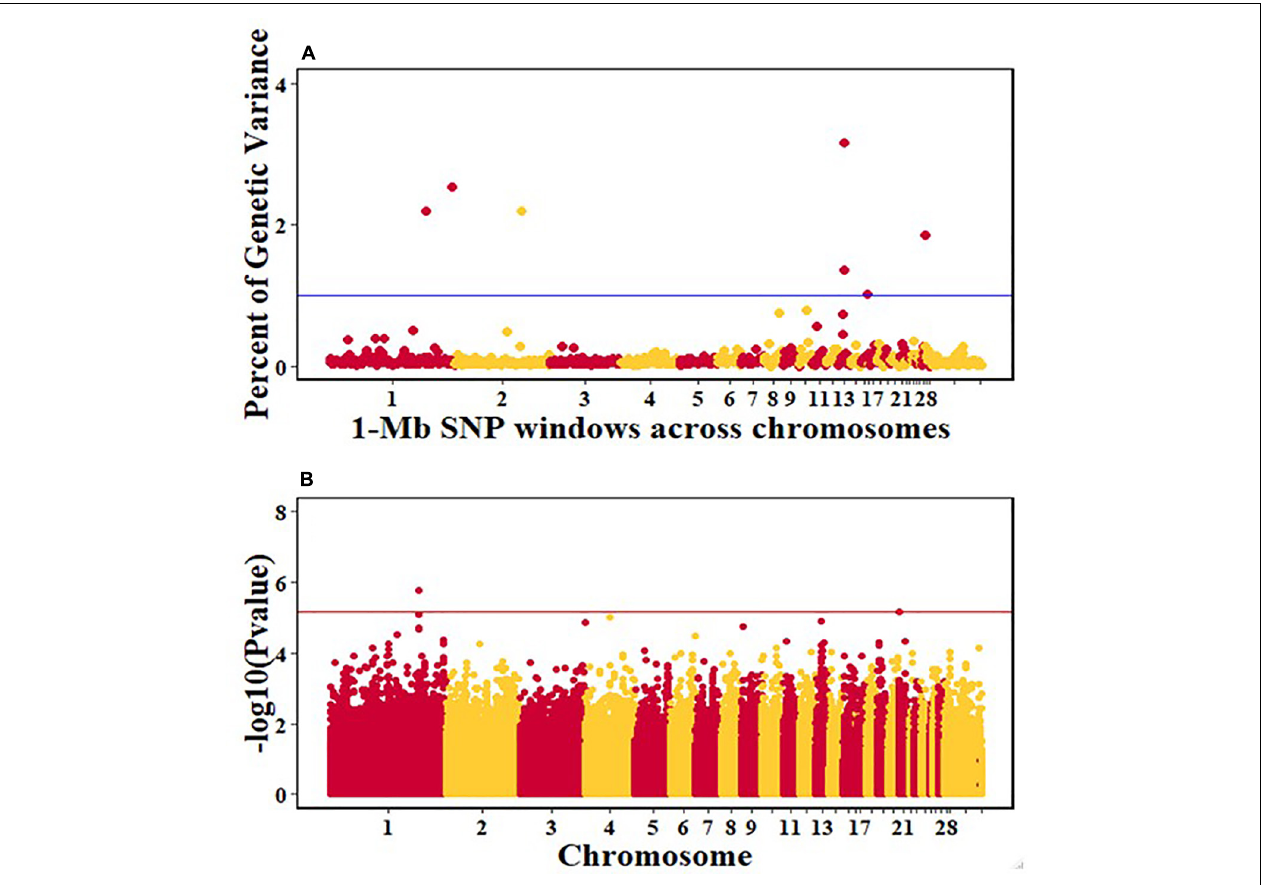
FIGURE 6 | Manhattan plots showing the genome-wide association results for viral load at 2 dpi in the Ghana local chicken ecotypes population, using Bayes-B and single-SNP analyses. (A) Bayes-B results show the percent of genetic variance explained by 1-Mb non-overlapping windows of SNPs across chromosomes. (B) Single-SNP results show the -log10(Pvalue) of ordered SNPs across the chromosomes. The blue and red lines indicate genome-wide significance at 1% genetic variance and 20% genome-wide suggestive association,